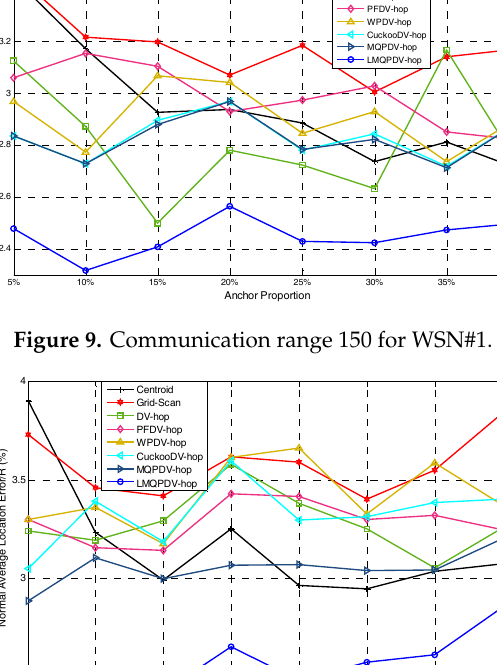
Figure 8. The effect of the number of anchors location on location error for WSN#2. Figure 8. The e ff ect of the number of anchors location on location error for WSN#2.